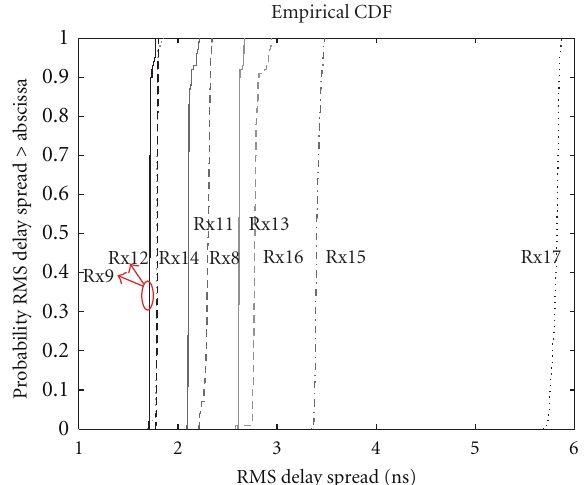
Figure 11: CDF of the measured RMS delay spreads for OLOS in the UWB band measurements.